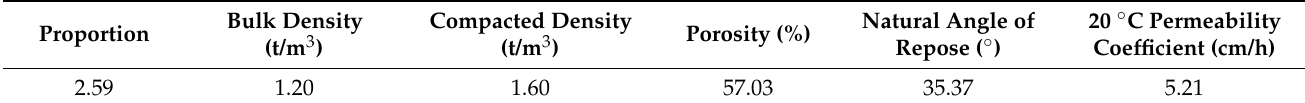
Table 1. Basic physical properties of experimental tailings.